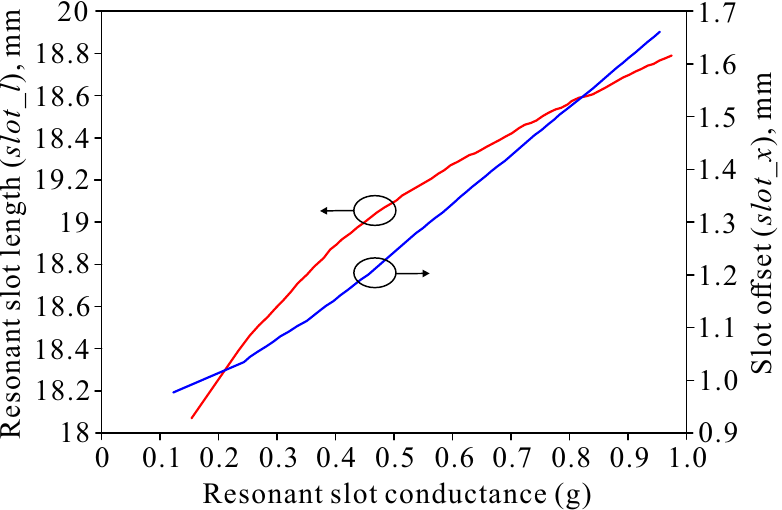
Figure 6. Parameter extraction curves of the resonant slot length and slot offset versus the resonant slot conductance for the VP